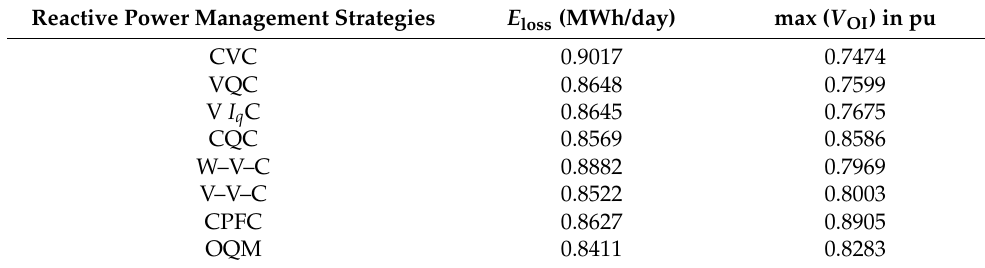
Table 4. Total energy losses and maximum overall voltage index of the day-ahead steady-state microgrid operation of the seven local-reactive power management and OQM strategies enabled in the smart